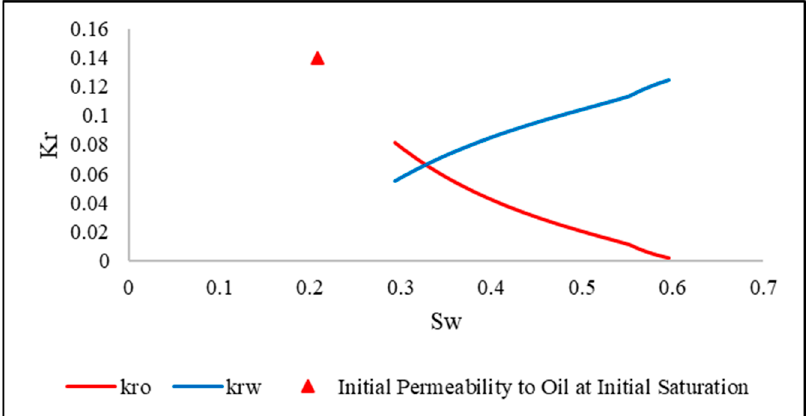
Figure 8. Post-breakthrough water–oil relative permeability curves for Copper Ridge dolomite.